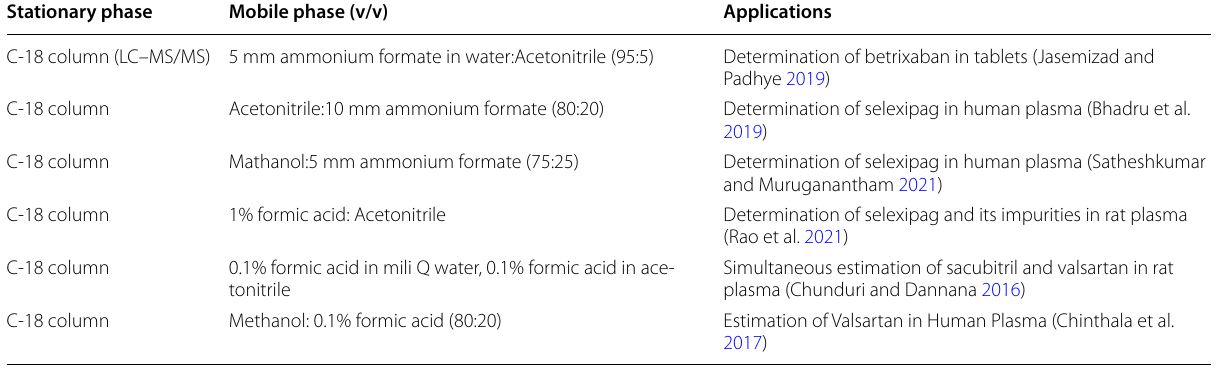
Table 5 LC-MS/MS, LC-MS methods for analysis of FDA-approved treatments for several cardiovascular illnesses from 2015 to